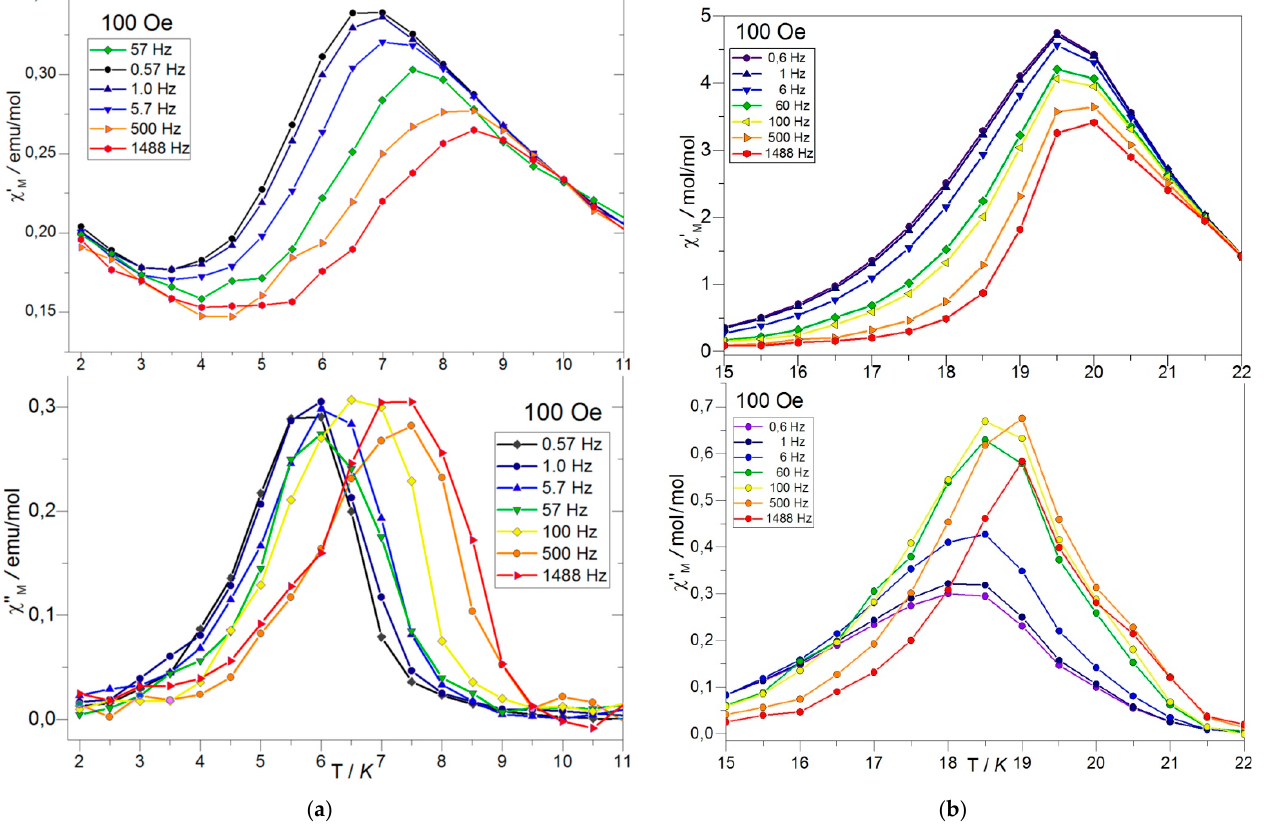
Figure 25. Variable temperature of the real ( χ ’ , top) and imaginary ( χ ” , bottom) parts of the ac molar susceptibility data collected under H dc = 100 Oe and H ac = 3 Oe. Solid lines are guides for ( a ) 14 and ( b ) 15 [56].